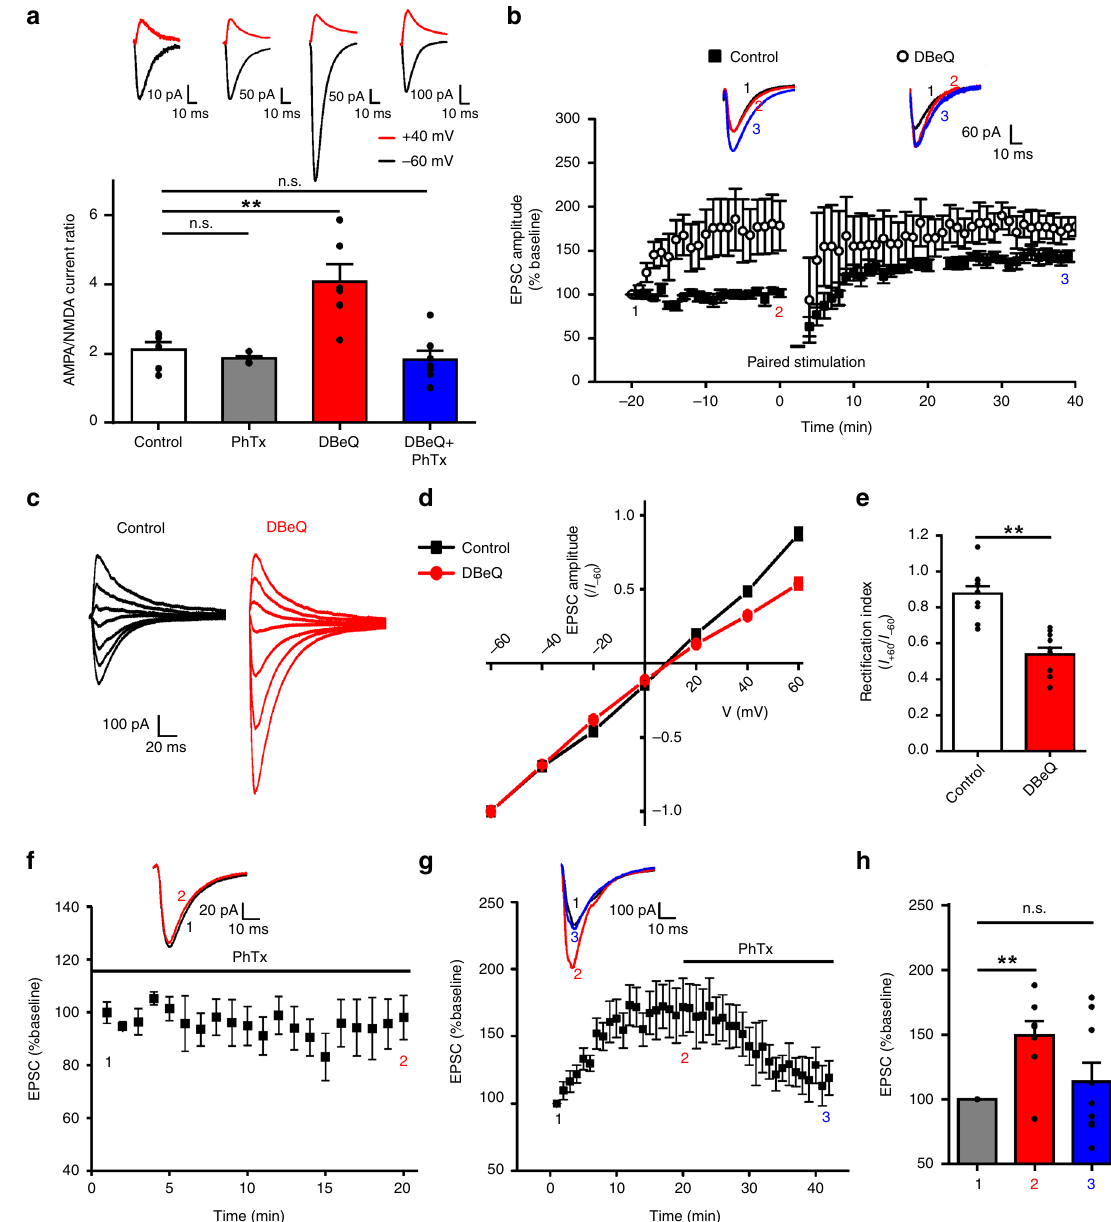
Fig. 7 Inhibition of p97 promotes native GluA1-homo AMPAR postsynaptic insertion in hippocampal slices. a Inhibition of p97 increases AMPA/NMDA ratio. Twenty minute after the formation of whole-cell con fi guration, AMPAR- and NMDAR-mediated EPSCs were evoked by electrical stimulation of schaffer collateral inputs at holding potentials of − 60 and + 40 mV, respectively. The AMPA/NMDA ratio was signi fi cantly increased by DBeQ (11 μ M; through the recording pipette) in the absence of PhTx, but not in the presence of PhTx (10 μ M; bath application throughout the recording) (Control: n = 6 cells; PhTx: n = 4 cells; DBeQ: n = 6 cells; DBeQ + PhTx: n = 7 cells; F = 11.01, p = 0.0002, one way ANOVA; ** p < 0.01, n.s. not signi fi cant, post hoc test). b Inhibition of p97 increases basal synaptic transmission, and occludes the induction of LTP. Paired stimulation protocol reliably induced LTP in neurons recorded with pipettes without DBeQ (Line with black squares; n = 6 cells). DBeQ (11 μ M) contained in recording pipettes increased basal EPSCs that prevented paired stimulation to produce LTP (Line with empty circles; n = 4 cells). c – e Inhibition of p97 changes the recti fi cation of AMPAR EPSCs. Twenty minute after the formation of whole-cell con fi guration, AMPAR mediated EPSCs were evoked by electrical stimulation of schaffer collateral inputs at holding potentials from − 60 to + 60 mV with a step interval of 20 mV. DBeQ (11 μ M) contained in recording pipettes shifted I-V curve to a more inward recti fi cation, as shown in representative traces ( c ), I – V curve ( d ), and recti fi cation index ( I + 60/ − 60 mV ; e ) (Control: n = 10 cells; DBeQ: n = 10 cells; ** p < 0.01, two-tailed t test). f Bath application of PhTx (10 μ M) immediately after the formation of whole-cell con fi guration blocked the run-up of AMPAR mediated EPSCs ( n = 8 cells). g , h PhTx (10 μ M), bath applied 20 min after the formation of whole-cell con fi guration when AMPAR mediated EPSCs reached the plateau, reversed the EPSC run-up, decreasing the EPSC amplitude back to the baseline level within 20 min of PhTx application ( n = 9 cells; F = 5.842, p = 0.0089, one-way ANOVA; ** p < 0.01, n.s. not signi fi cant, post hoc test). The error bars represent